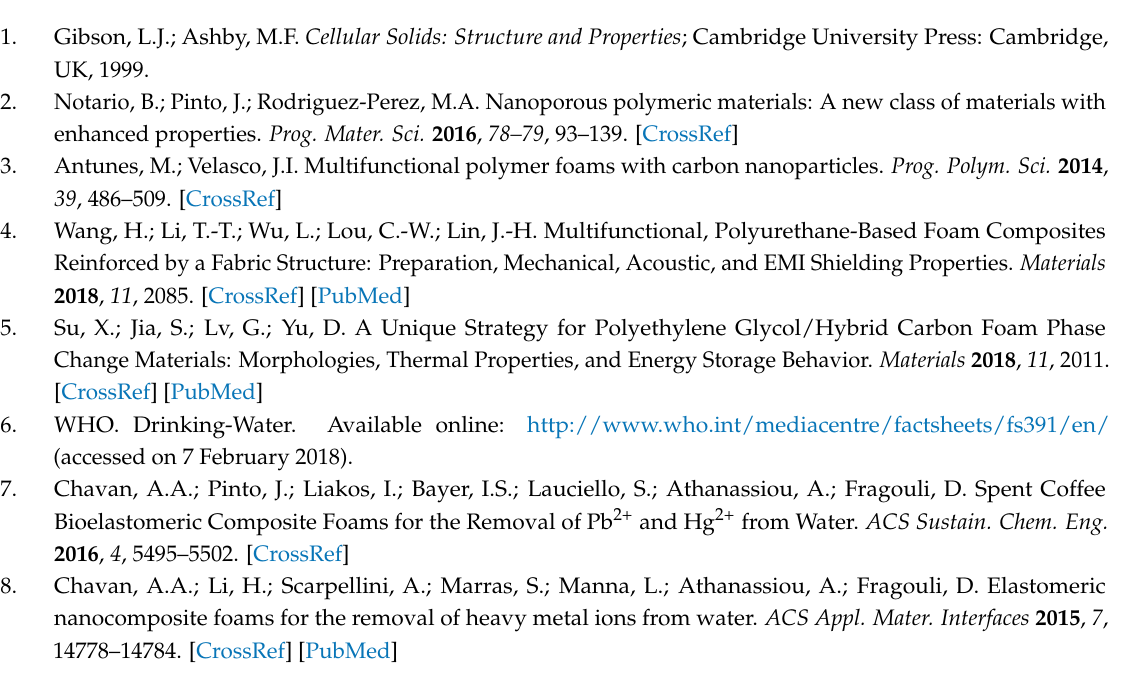
s1. Figure S1 . Spray-coating set-up. Figure S2 Optical micrographs of PUT obtained by modifying the distance between the nozzle head and the samples. Figure S3 . UV-Vis spectra of silica nanoparticles dispersed in ethanol (black), remaining ethanol after being in contact with treated foams not subjected to the initial washing procedure (red), and remaining ethanol after being in contact with treated foams subjected to the initial washing procedure and absorption tests (blue). Figure S4 . Water drop placed in a PU pore, where θ is the real contact angle of water (WCA), and γ is the apparent contact angle (APCA) measured by the optical contact angle goniometer (a). Figures (b) and (c) illustrate the influence of the pore size on the apparent contact angle of water drops with the same size. Figure S5 . Schematic representation (a) and photograph (b) of the absorption tests set-up. Figure S6. Water and oil absorption capacity using PU and PUT foams. Figure S7. FTIR spectra of PU foams and TPU (a), PUT samples after 1 (PUTW1), 2 (PUTW2), 3(PUTW3), 4 (PUTW4), and 5 (PUTW5) washing cycles (b), and PUT samples after 5, 15 (PUTW15), 25(PUTW20), and 50 (PUTW50) washing cycles (c). Table S1. Mass Increase of PUT foams obtained using different spray-coating distances and their stability during five consecutive washing cycles. The first one is part of the production route of the treated foams, as described in section 2.2, while the following four cycles are perfomed to study the stability of the treatment once the treated foams has been produced. Table S2. Oil and water absorption capacity of PU and PUT